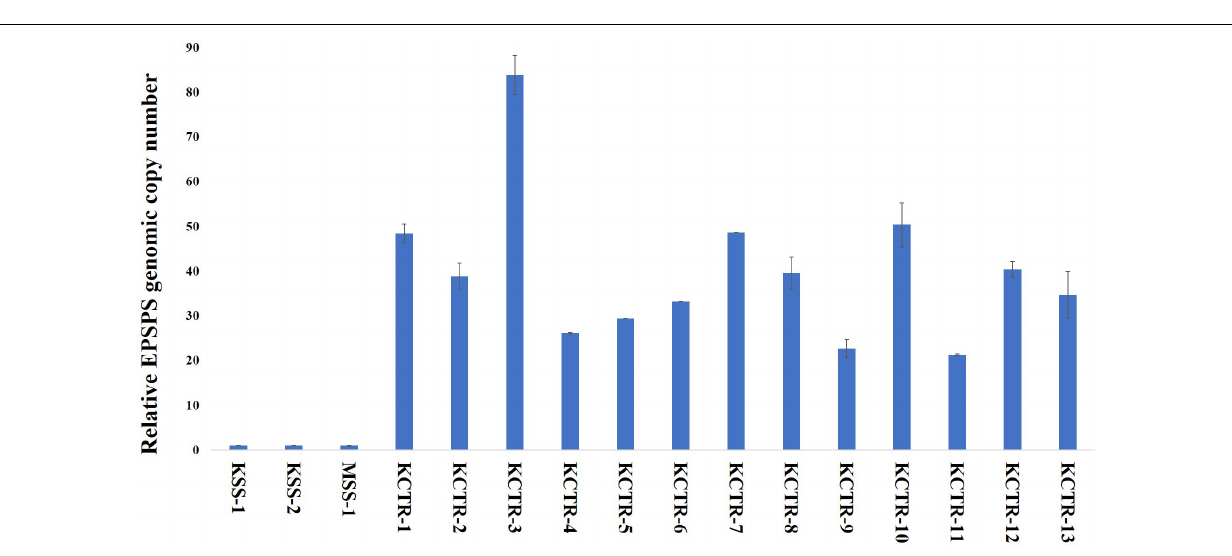
FIGURE 4 | EPSPS genomic copy number in glyphosate-susceptible (MSS and KSS) and glyphosate-resistant (KCTR) Palmer amaranth plants relative to the susceptible plants. KCTR plants were treated with the recommended field rate of glyphosate. Error bars represent the standard error from the mean (2 runs and in each run 3 technical replicates). The qPCR data was normalized using β -tubulin as the reference